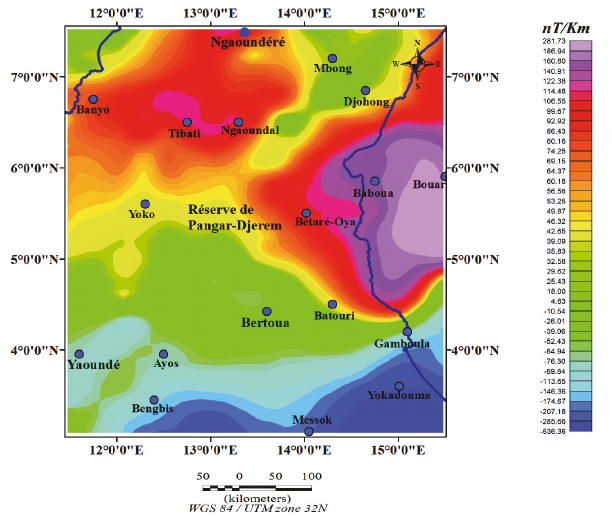
Figure 4: Total magnetic intensity map reduced to the equator (TMI-RTE).